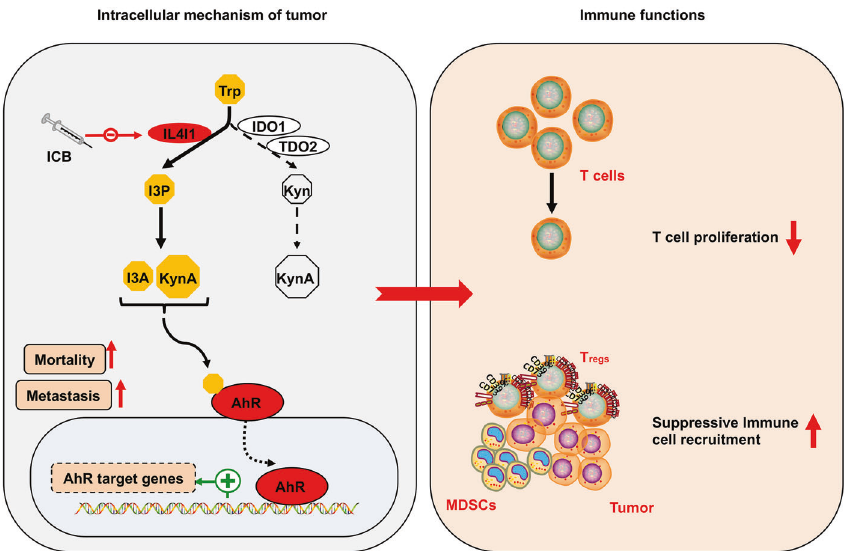
Fig. 1 Newly identi fi ed IL4I1 which is induced by immune checkpoint blockade (ICB) mediates AHR signature genes through I3P-KynA/I3A metabolic pathway parallel to IDO1 and/or TDO2-driven AHR signaling. On one hand, IL4I1 can promote cancer cell motility and metastasis, on the other hand, it also inhibits T-cell proliferation and recruits suppressive immune